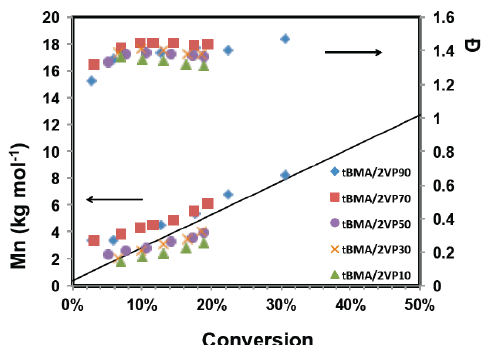
Figure 2. Number-average molecular weight ( M n ) and dispersity ( Đ ) of the statistical copolymers of t BMA and 2VP measured by GPC relative to poly(methyl methacrylate) standards versus conversion; solid line represents the theoretical M n trend.